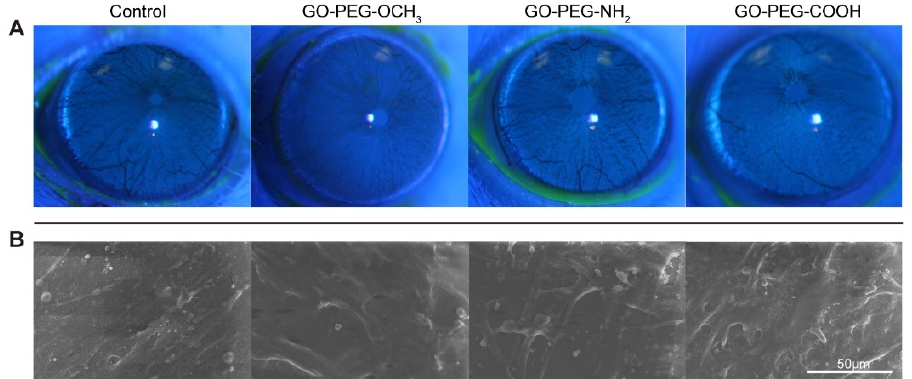
Figure 4. Ocular surface irritation test of PEG-GO nanosheets. ( A ) Corneal fluorescein staining of Sprague Dawley (SD) rats at 24 h post PEG-GO treatment. ( B ) Scanning electron microscope micrographs of the cornea at 24 h after PEG-GO treatment.